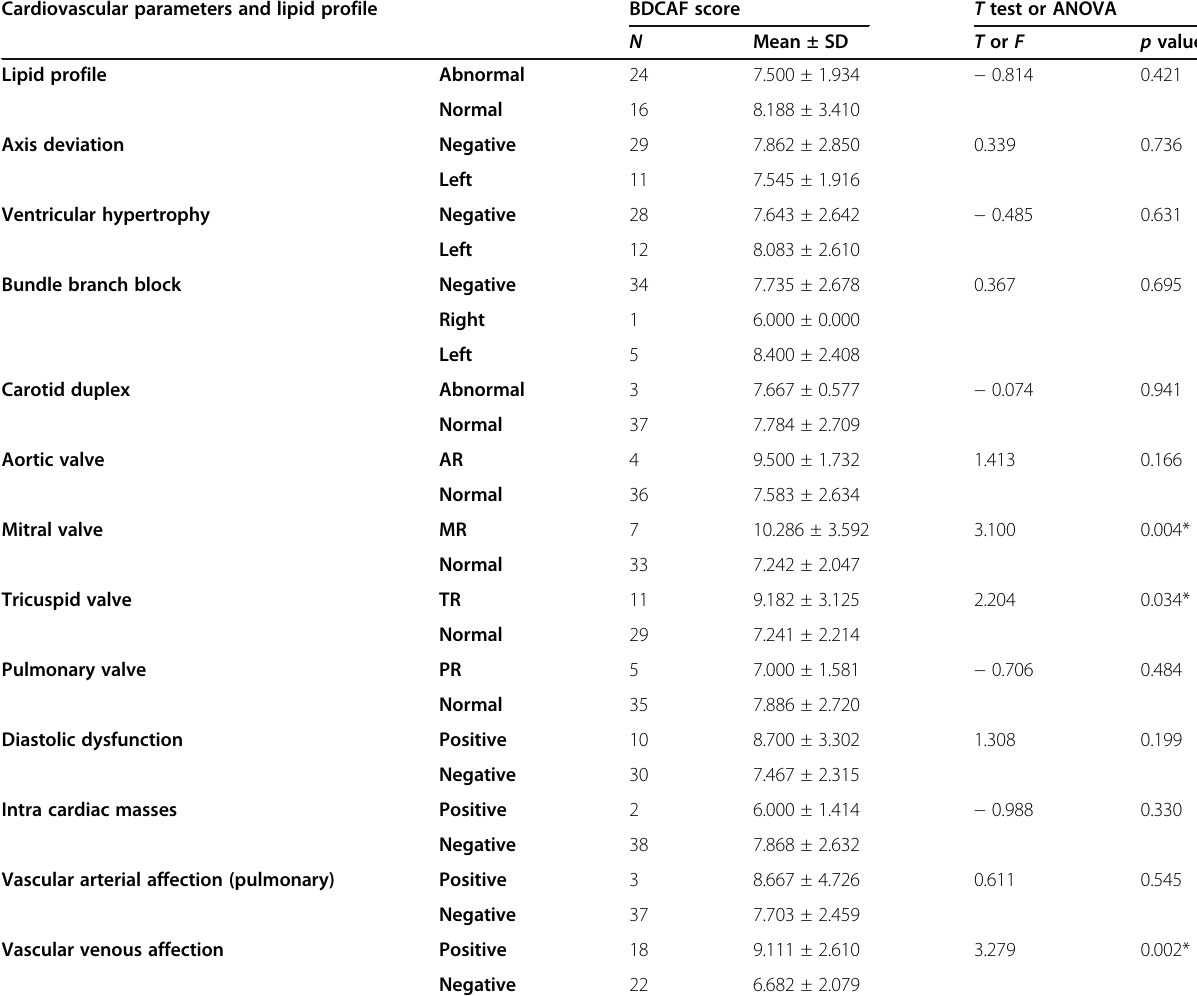
Table 3 Comparisons of Behçet patients with different cardiovascular characteristics regarding disease activity score Cardiovascular parameters and lipid